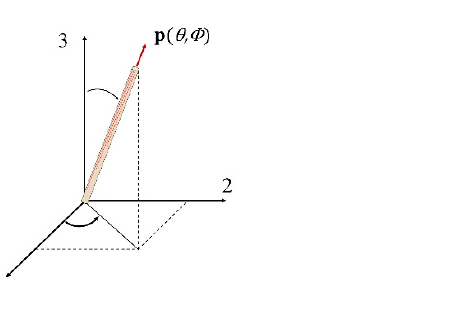
Figure 3. Representation of the orientation of a single rigid fiber by the vector p ( θ , φ )